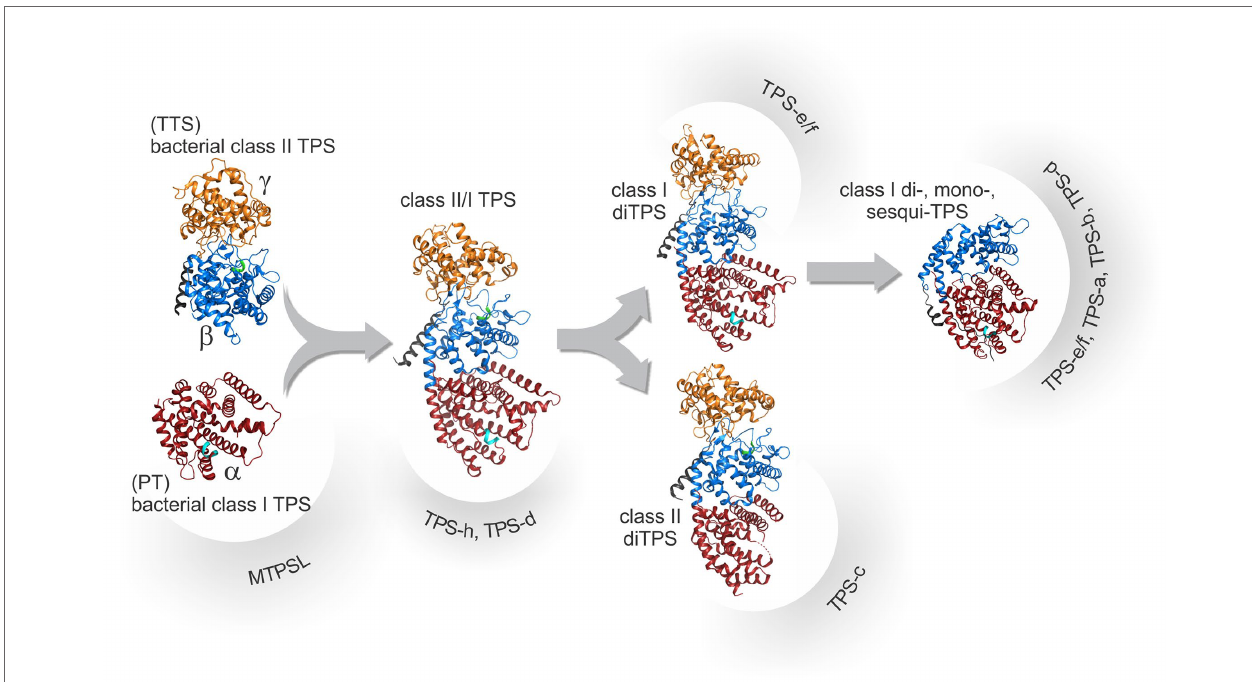
FIGURE 3 | Schematic overview of the proposed structural and evolutionary relationships among terpene synthases (TPSs) as based on known protein structures. Proposed progenitors of TPSs include ancestral bacterial class II diTPSs with a signature α -barrel βγ -domain harboring a catalytic DxDD motif, here exemplified by the ent -copalyl diphosphate synthase from Streptomyces platensis (PDB 5BP8; Rudolf et al., 2016). These, in turn, are related to ancestral triterpene synthases (TTS) and bacterial class I diterpene synthases (diTPSs) that adopt the signature α -domain structure with a conserved DDx 2 D motif, here exemplified by ent- kaurene synthase from Bradyrhizobium japonicum (PDB 4W4R; Liu et al., 2014) closely related to ancestral prenyltransferases (PT). Fusion of the ancestral monofunctional genes will have given rise to diTPSs with three helical domains ( αβγ ) represented here by Abies grandis abietadiene synthase (PDB 3S9V; Zhou et al., 2012a). Duplication and subsequent loss of activity in the βγ - and α -domains, respectively, lead to the emergence of monofunctional plant class II, here represented by Arabidopsis thaliana ent -copalyl diphosphate synthase, (PDB 4LIX; Köksal et al., 2014) and class I diTPSs, here represented by Taxus brevifolia taxadiene synthase (PDB 3P5P; Köksal et al., 2011). Through further loss of the γ -domain and various neo-functionalization and specialization events, the large classes of βα -domain class mono- and sesqui-TPSs will have arisen. Domain colors illustrate the γ -domain (orange), the β -domain (blue), the α -domain (red), as well as the conserved DxDD (green) and DDx 2 D (cyan)